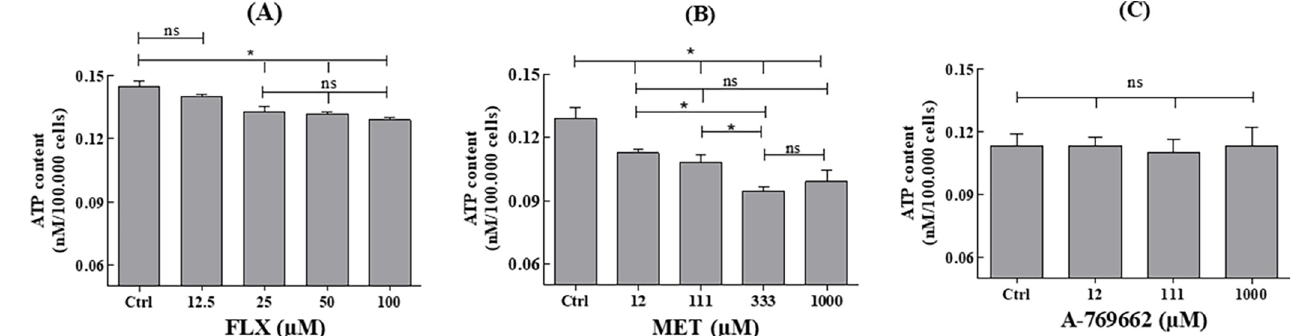
Fig 9. Effect of FLX or MET or A-769662 on ATP concentration in MLTC-1 cells. ATP concentration in living cells was monitored using the Cell-Titer-Glo Assay. Cells were incubated at 37˚C in the presence or absence of FLX (A) or MET (B) or A-769662 (C). The experiments were repeated 6 times independent experiments, values (%) are mean ± SEM (n = 6). Results were analyzed by one-way ANOVA, followed by the Dunnett’s test posttest). � : significant difference ( � P < 0.05), ns: no significant